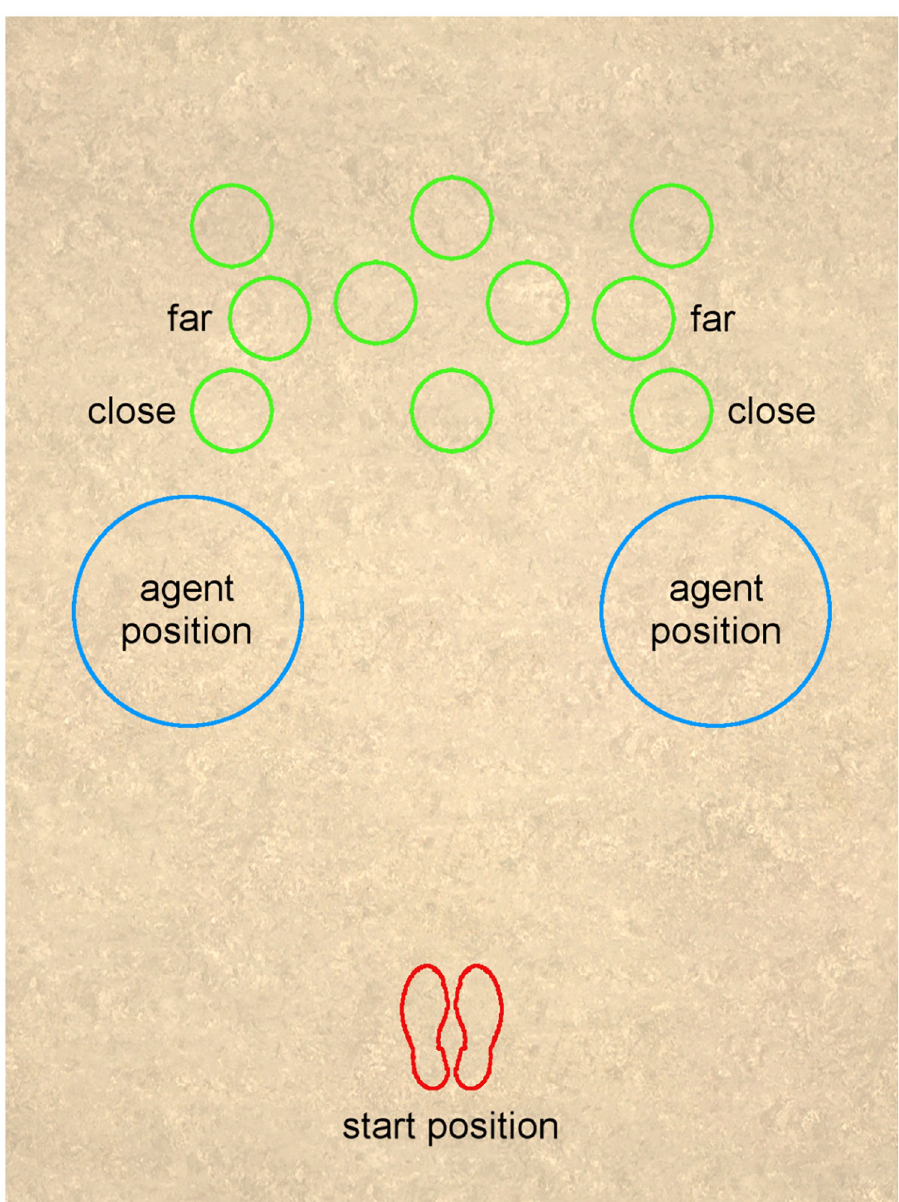
Fig 1. Projection on CAVE floor. Floor of the CAVE from above showing outlines for the start position (red) and all possible target positions (green), as well as the possible agent positions (blue) and the four “targets of interest” positions, labeled as close and